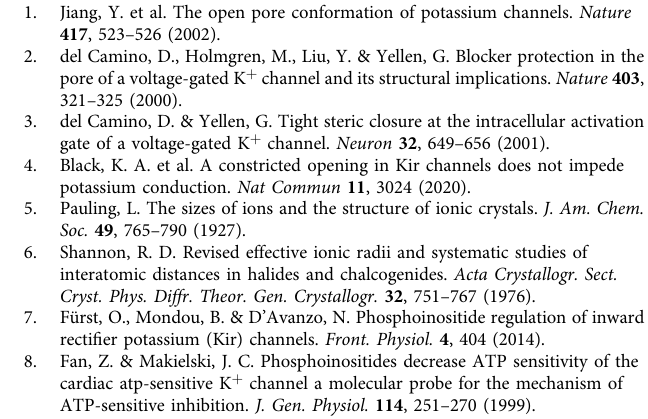
Figshare server as Lipidomics raw data for KirBac [https://doi.org/10.6084/ m9. fi gshare.17197811.v1]. Source data are provided with this